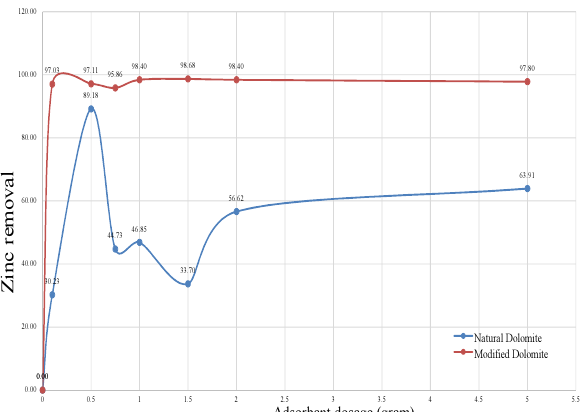
Fig. 7. Comparison of removal rate of zinc from natural dolomite (5 mg/l) and modified dolomite with contact time of 60 minutes in specified adsorbents